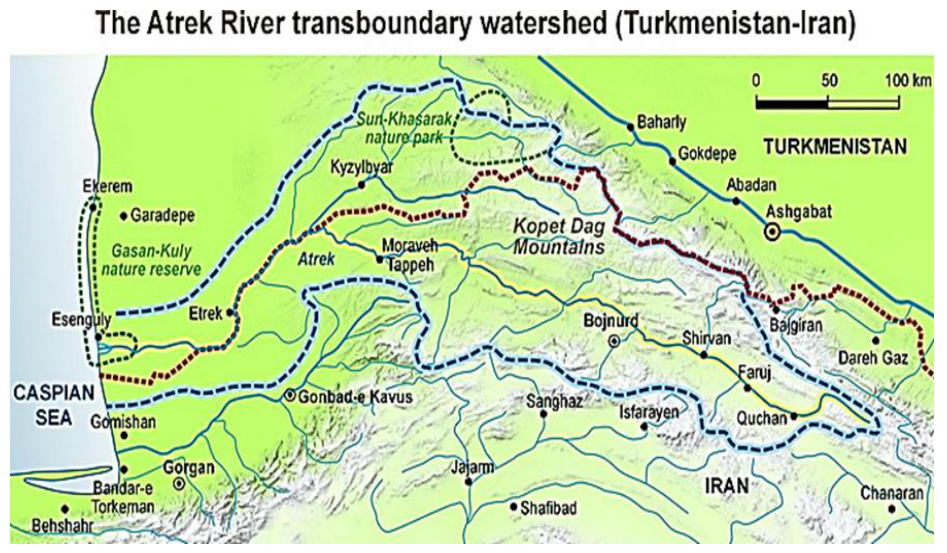
Figure 1. Atrek Basin.